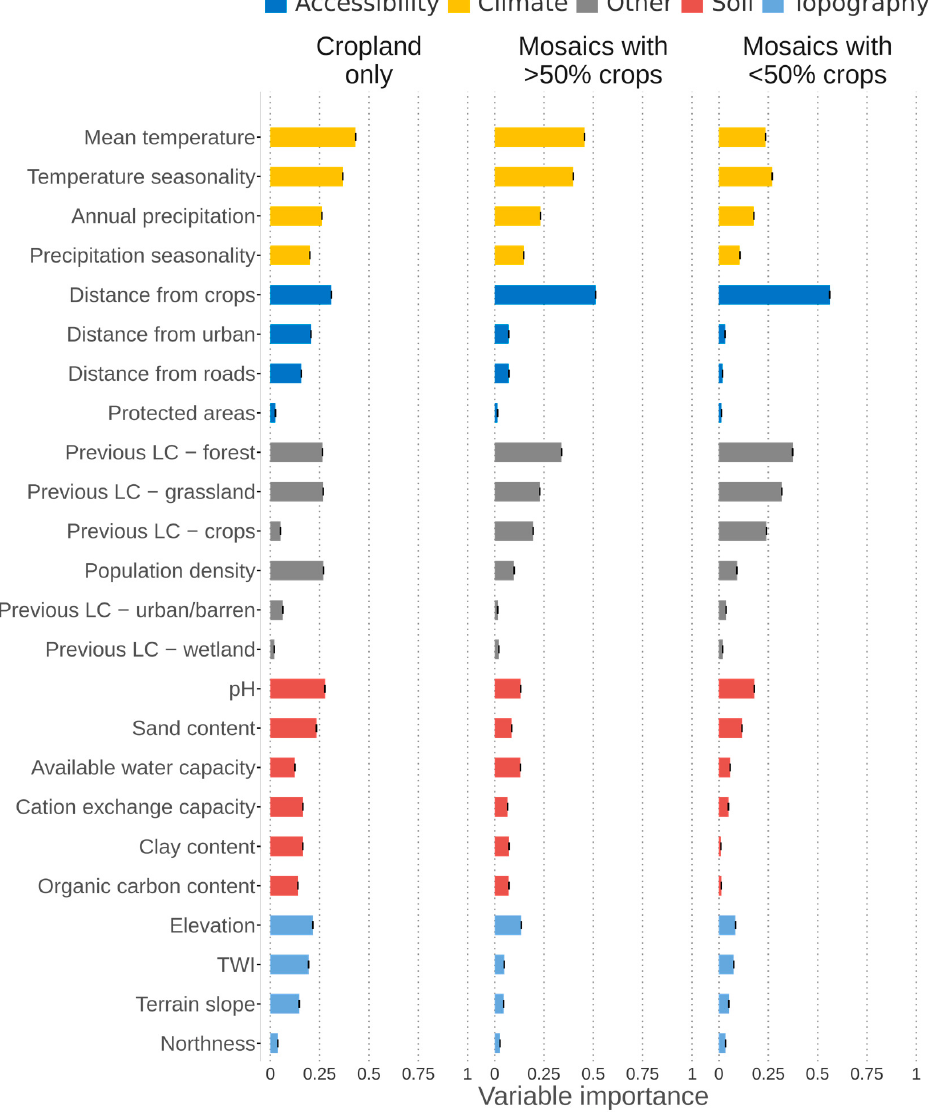
Figure 3. Importance of the predictor variables for the conversion potential into three categories of agricultural land: cropland only ( left ), mosaics with >50% crops ( centre ), and mosaics with <50% crops ( right ). Bars and error bars represent the means and standard errors based on 100 repetitions of the variable importance estimation procedure. LC = land cover; TWI = topographic wetness index.